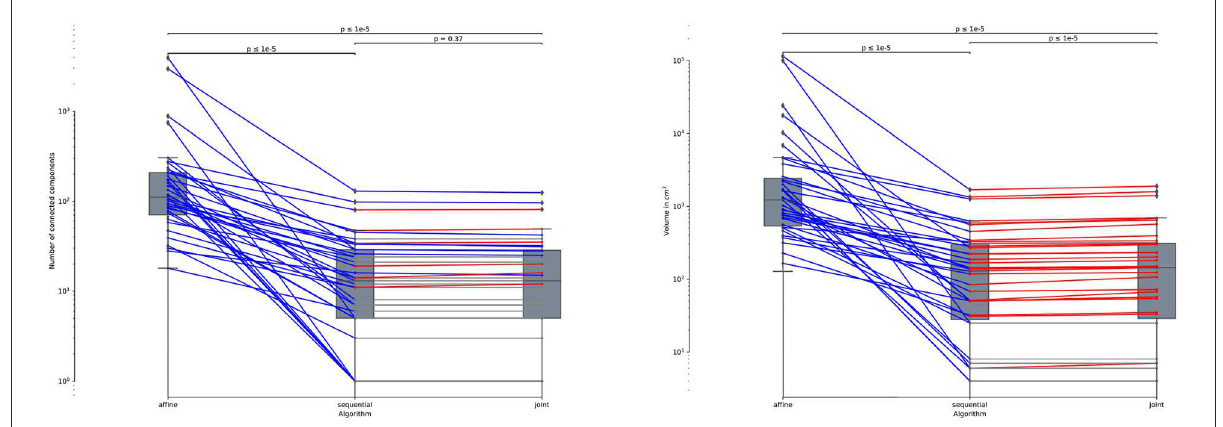
FIGURE10 Number of connected components (left) and volume in cm 3 (right) of the detected changes computed for the 39 subjects of MSSEG-2-NoChange datasets (i.e., subjects without new appearing lesion). Statistical significancy is evaluated thanks to the Wilcoxon signed-rank test between each pair of methods while appling Benjamini/Hochberg FDR